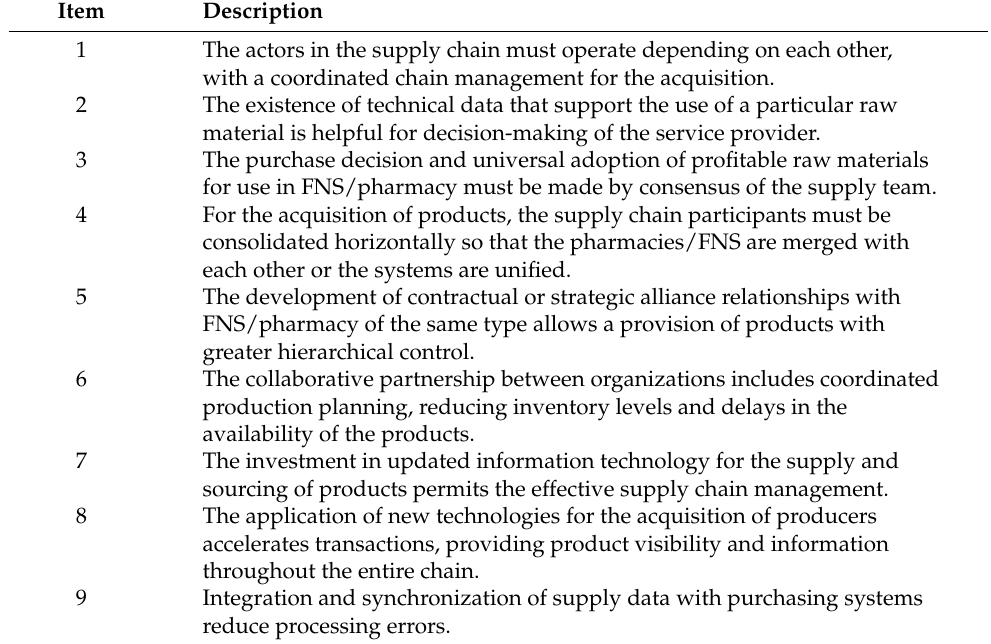
Table 3. Items and their descriptions adapted from scientific literature to evaluate the SFSCM model in pharmacies and